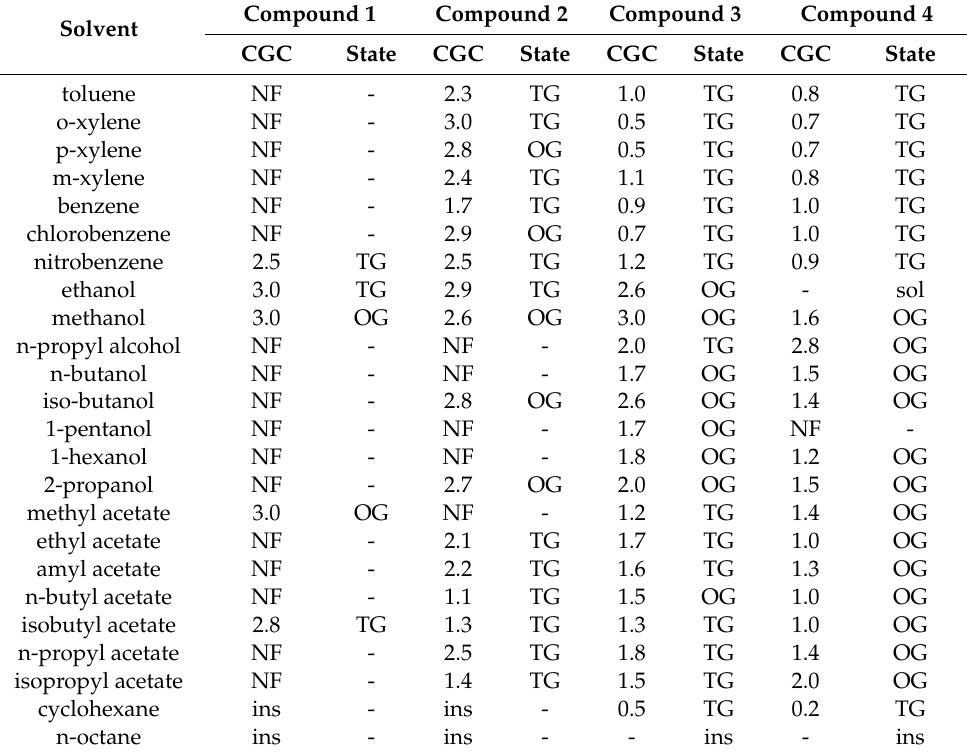
Table 1. Gelation ability of compounds 1, 2, 3, and 4 in some organic solvents.